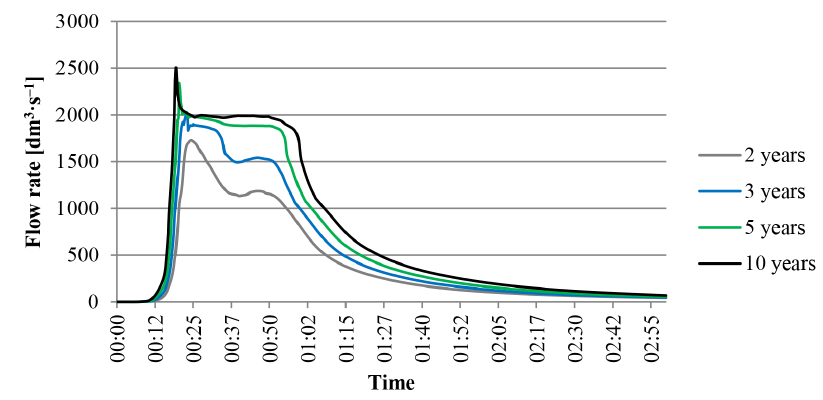
Figure 7. Changes in the intensity of flow through channel Link-30 – existing system prior to